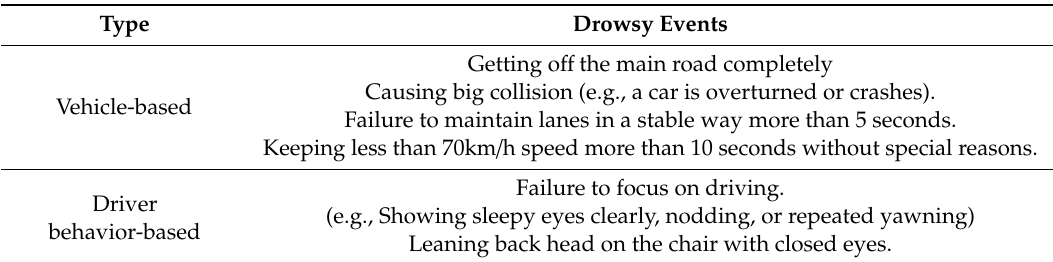
Table 1. The criteria to define drowsy events.